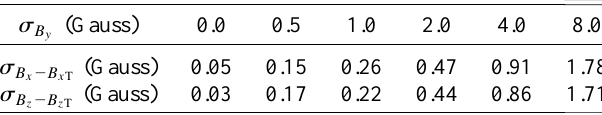
TABLE I. Deviation of B x and B z from the TOSCA results B x T and B z T for various noise levels of B y